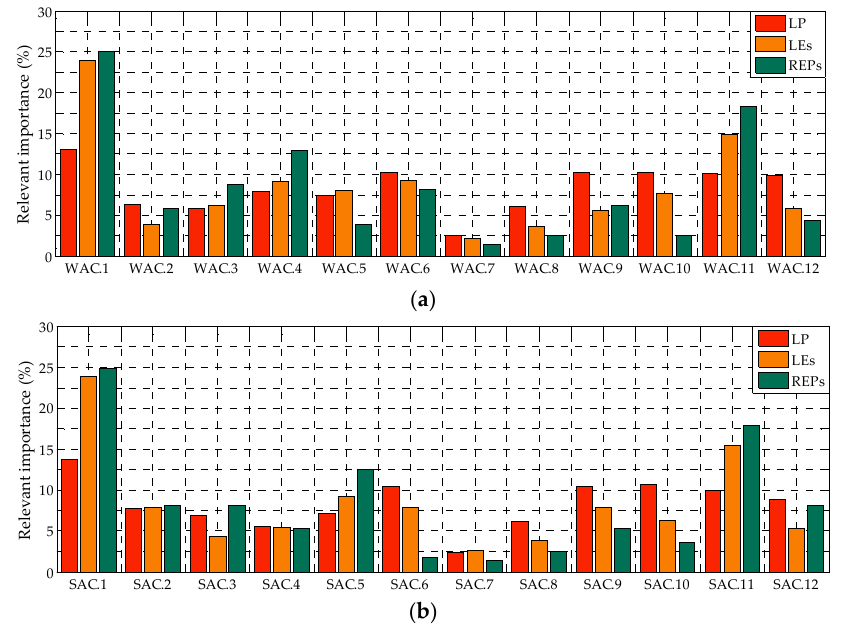
Figure 3. Relevant importance (%) of ( a ) Wind Assessment Criteria (WAC) and ( b ) Solar Assessment Criteria (SAC) based on Local Public (LP), Local Experts’ (LEs’), and Renewable Energy Planners’ (REPs’) opinion.